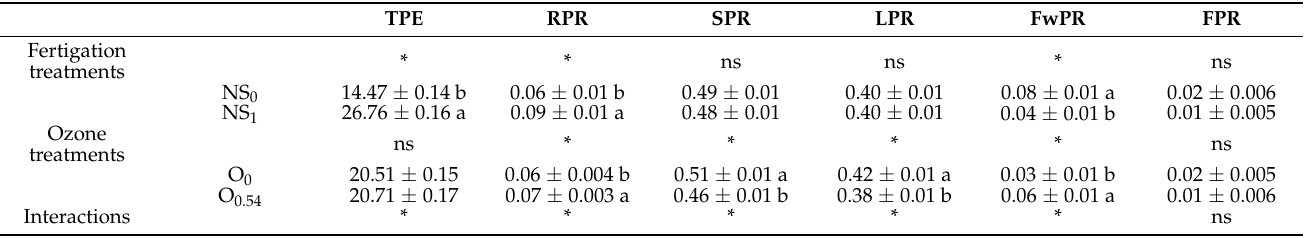
Table 13. Effect of fertigation and ozone on total phosphorus extracted by plant (TPE) (mg plant − 1 ) and their distribution in root (RPR), stem (SPR), leaf (LPR), flower (FwPR), and fruit (FPR) (dimen- sionless). The data recorded are the means ± standard deviation of four samples per treatment at the end of the experimental period. In each column, different letters or an asterisk (*) denote statistically significant changes between treatments (LSD test; p < 0.05). ns indicates non-statistical differences between